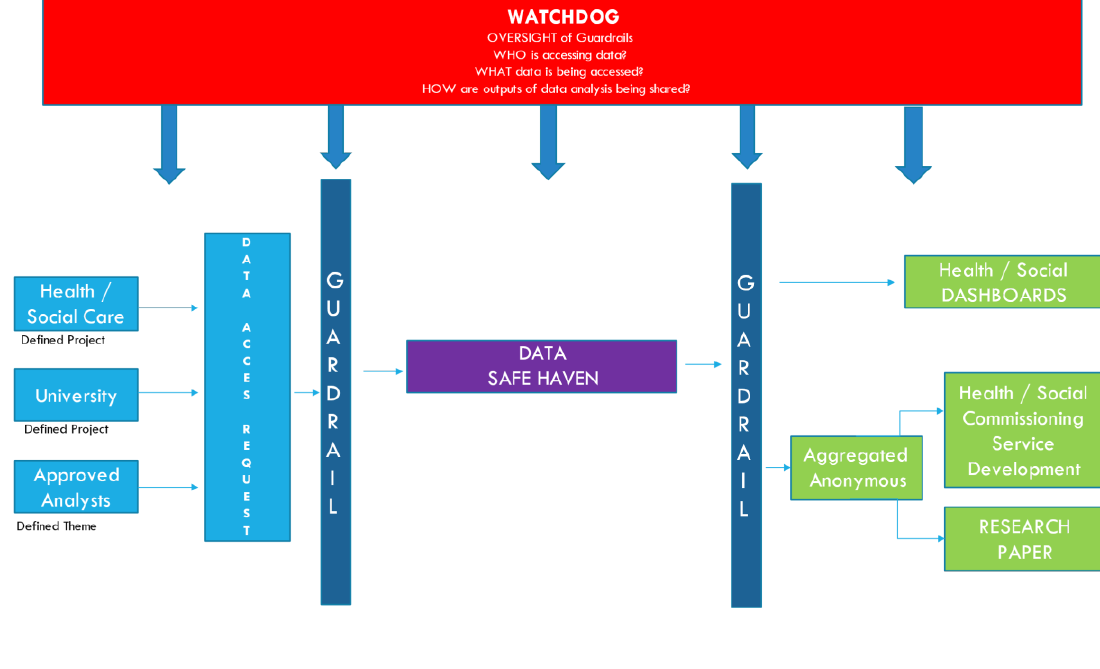
Figure 3: A depiction of how data would be kept safe and accessed by trusted users as proposed by Sussex